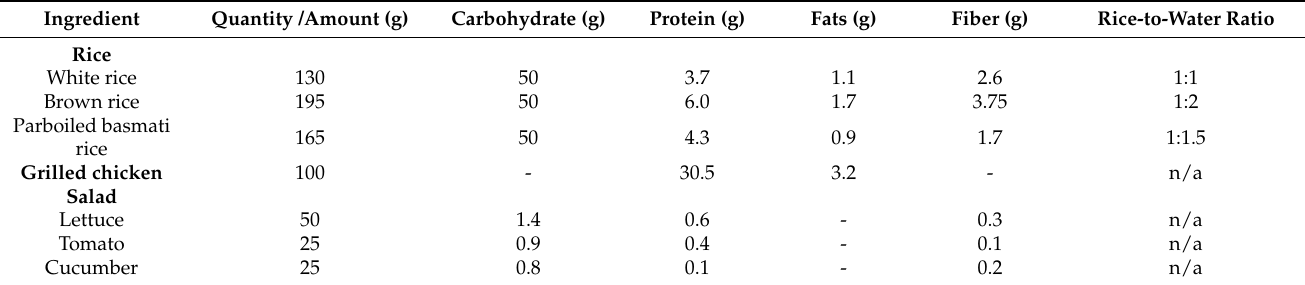
Table 1. Nutrient composition and serving sizes of mixed